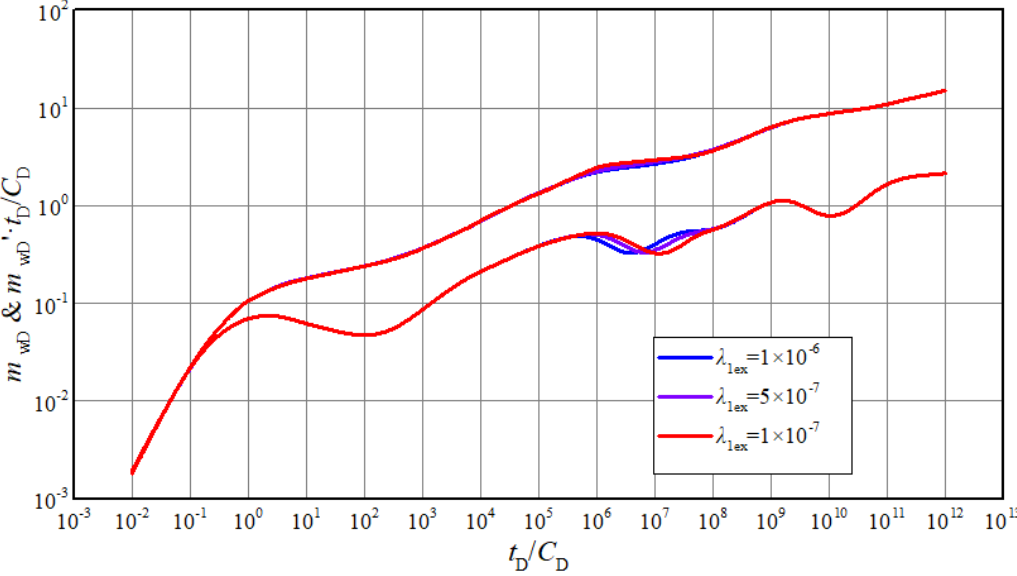
Figure 8. The effect of inter-porosity flow coefficient of inner region on typical curves.